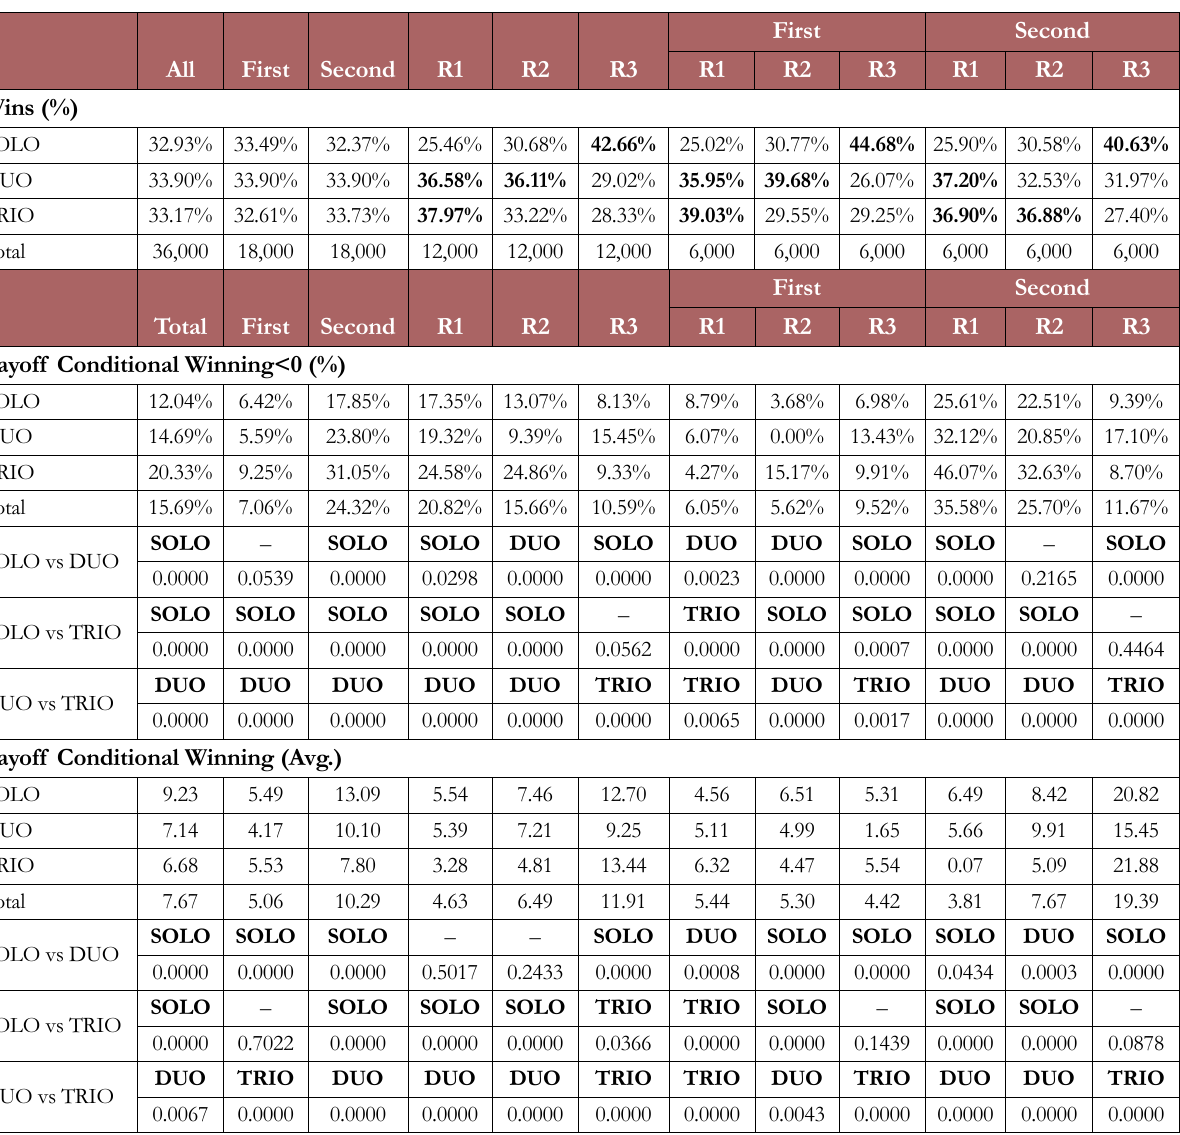
Table A2.4. Experimental game and payoffs conditional on winning: pairwise differences in terms of size by right